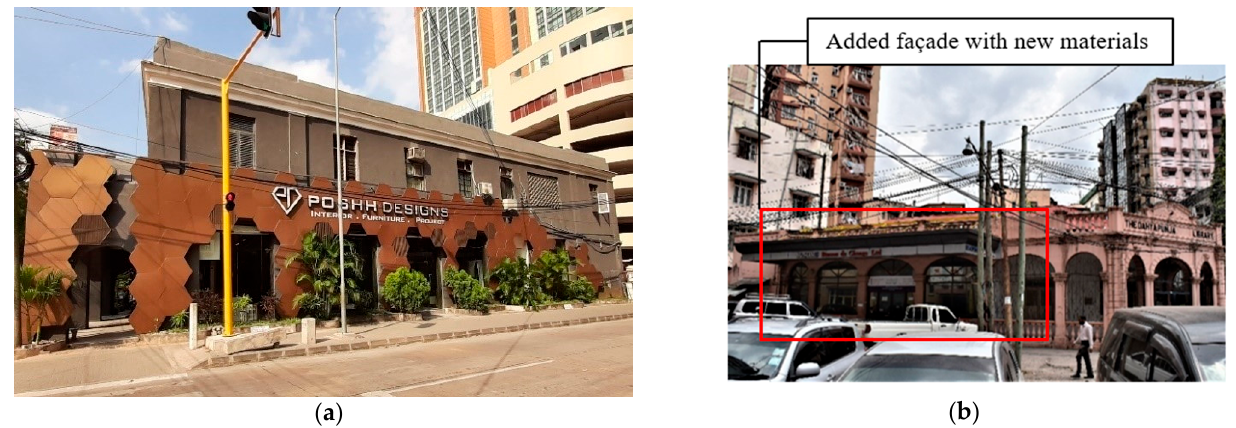
Figure 2. ( a ) Building at the corner between Samora Avenue and Morogoro Road with facades changed to accommodate